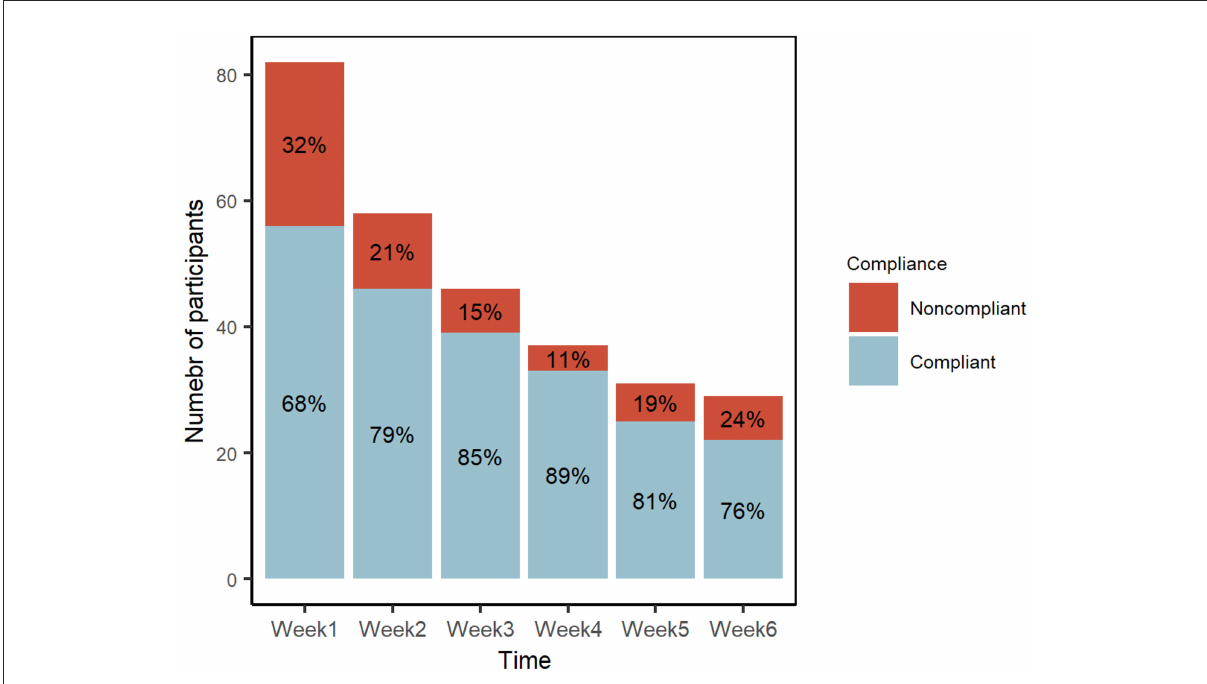
FIGURE2 Proportions of compliant and non-compliant participants over the study